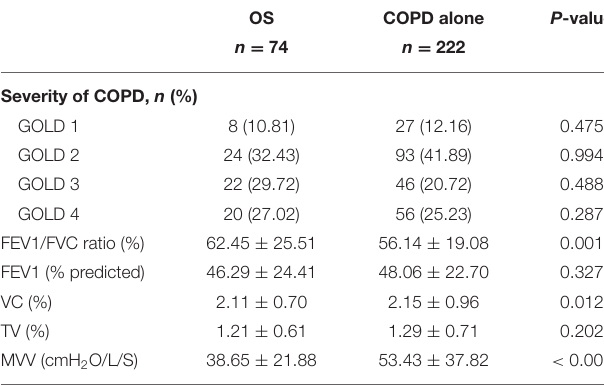
TABLE 2 | Polysomnographic findings of the study population. OS OSA alone